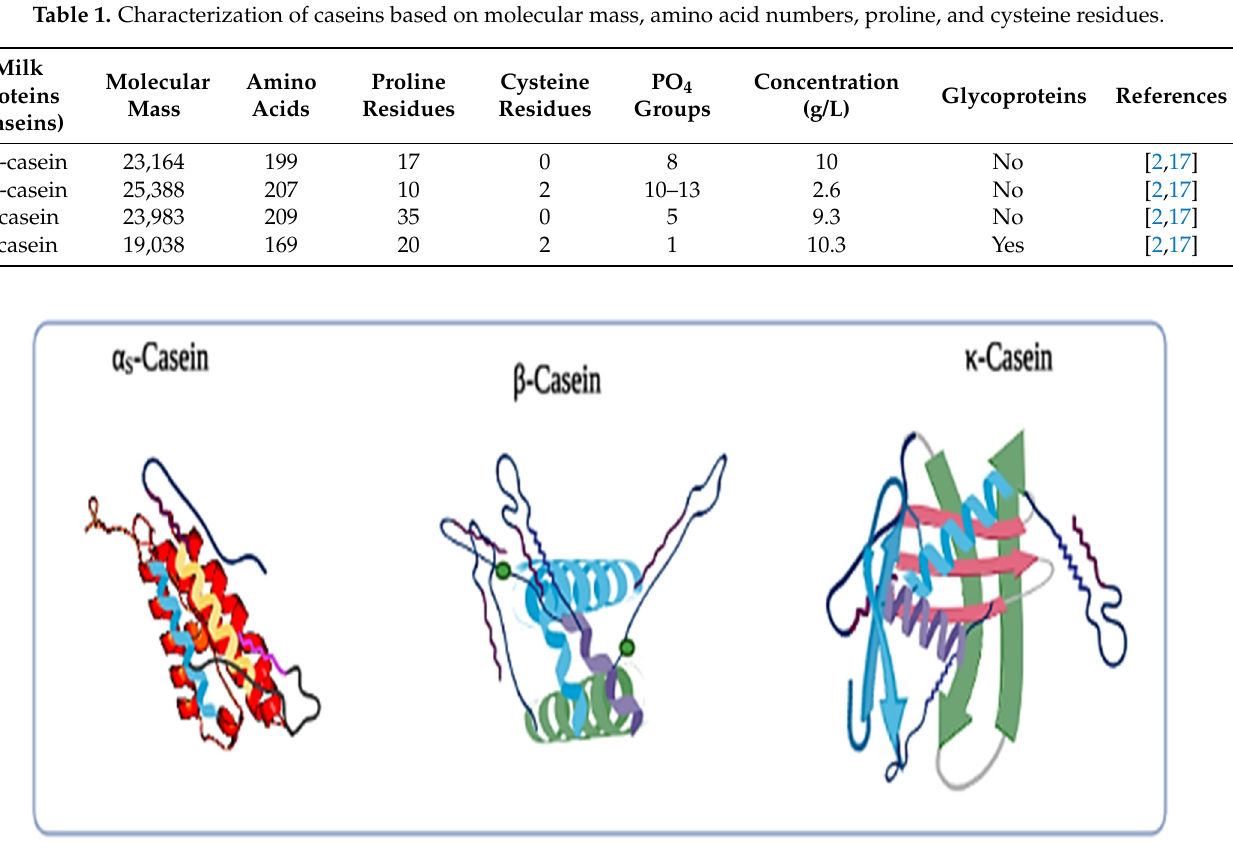
Figure 1. Polymeric structure of different fractions of casein protein. Casein exists in fresh milk in the form of a micelle structure, which is a complex aggregate of proteins ( α s1 -casein, α s2 -casein, β -casein, κ -casein, and several minor proteins) and colloidal phosphate calcium.